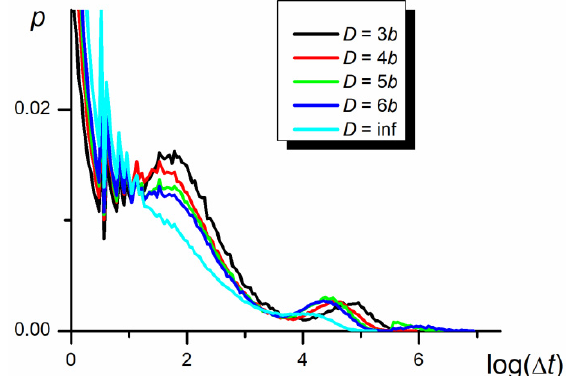
Figure 9. The probability density functions of periods, Δ t, between swapping of P1 and P2 mass centers in the logarithmic scale for different chain lengths ( t E = 5 × 10 7 , D = 3 b , ε PP / k B T = 0 and − 1 for P1 and P2, respectively).